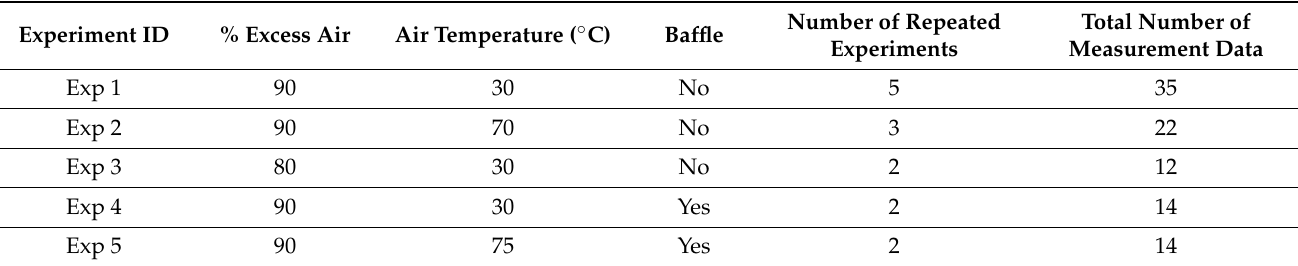
Table 1. Operating conditions in the main experimental plan.